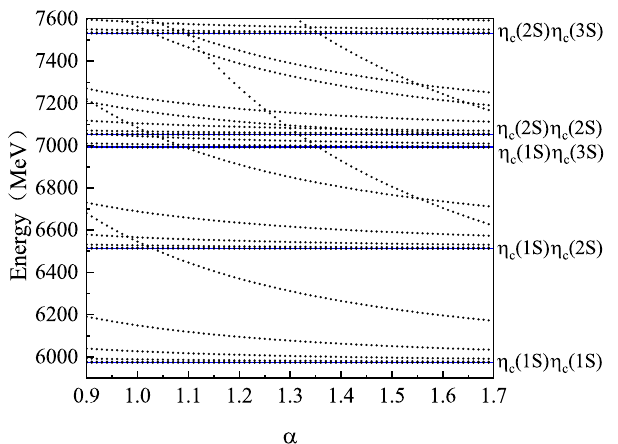
Figure 1. The stabilization plots for the energies of ( η c η c ) 0 state of J PC = 0 ++ with respect to the scaling factor α . The horizontal axis shows the value of α and the vertical axis represents the energy of the states, which is the same for the following figures.